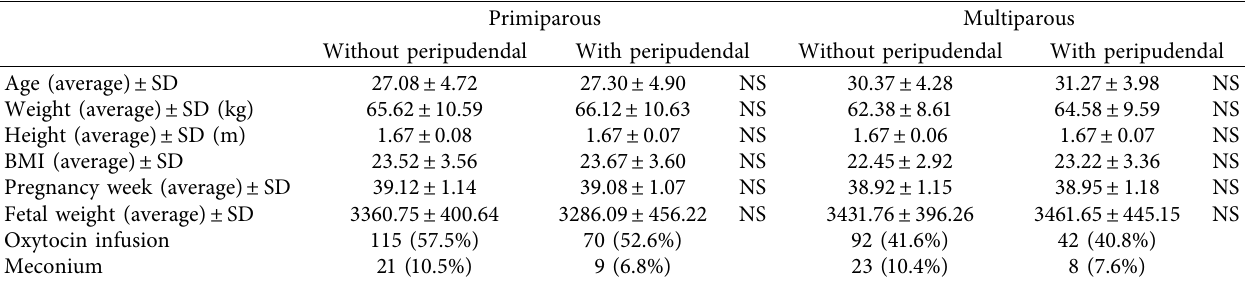
Figure 4: The difference between the amounts of drug administered for peripudendal block (PPB) and pudendal nerve block (PNB). (a) For peripudendal block (PPB), only 4ml of local anaesthetic is administered per side, as opposed to the 10 ml of the drug described for conventional pudendal nerve block (PNB). (b) Due to the smaller amount of the drug, there is no risk of vaginal injury when the skull passes through. A smaller amount of local anaesthetic administered is also effective and avoids vaginal injury due to a too large (oversized) protuberance as the skull passes through the cavity. Table 1: Statistical comparison of demographic and clinical data of the studied